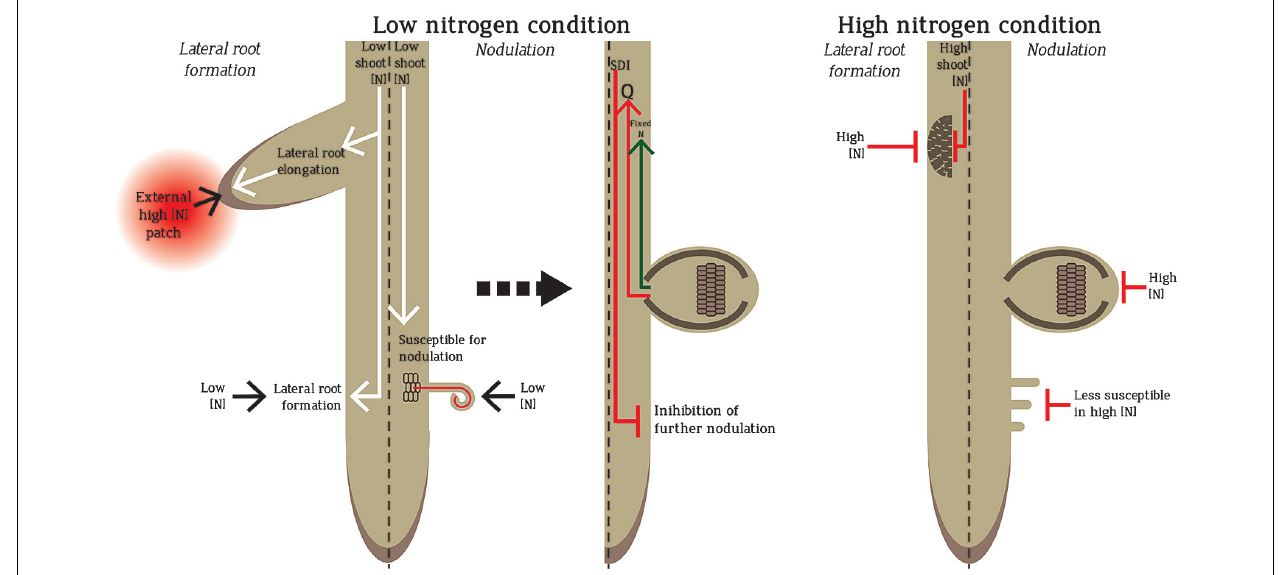
formation of nodules also sends a root-derived signal “Q” to the shoot, which triggers the production of a shoot-derived inhibitor (SDI) that travels back to the root to inhibit further nodulation. In homogenous high N conditions, both lateral roots and nodules are inhibited. In high N, the root is less susceptible for nodulation and infection, nodule number development and N fixation capacity are reduced. High shoot N also leads to less lateral root